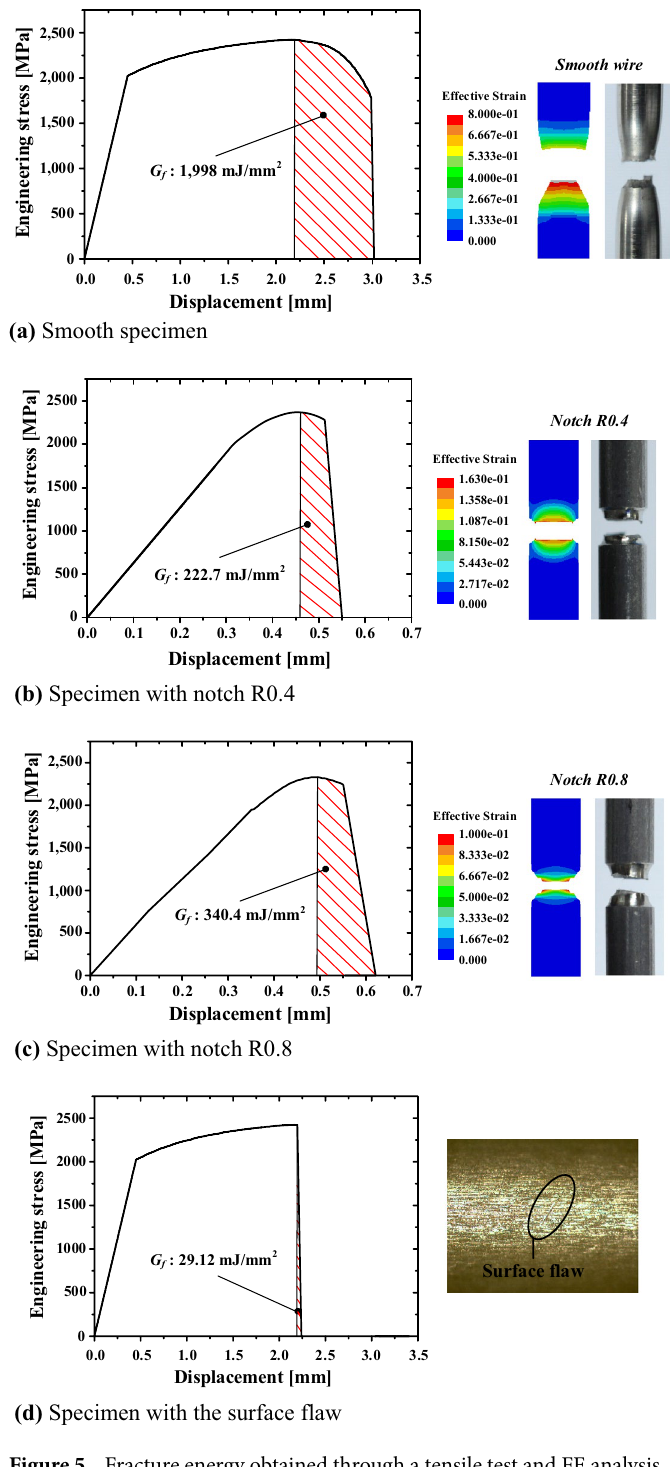
notch R0.4 or R0.8 derived from tensile tests and FE analysis. The fracture energy corresponds to the area from necking to the time of fracture in a true stress–displacement curve. The fracture energy of an OT wire with fine surface flaws was predicted through a tensile test on an OT wire with a flaw deeper than 40 µm, as shown in Fig. 5d. Ten specimens with a flaw were used in the tensile test, and the average fracture energy was evaluated to be 29.12 mJ/mm 2 .